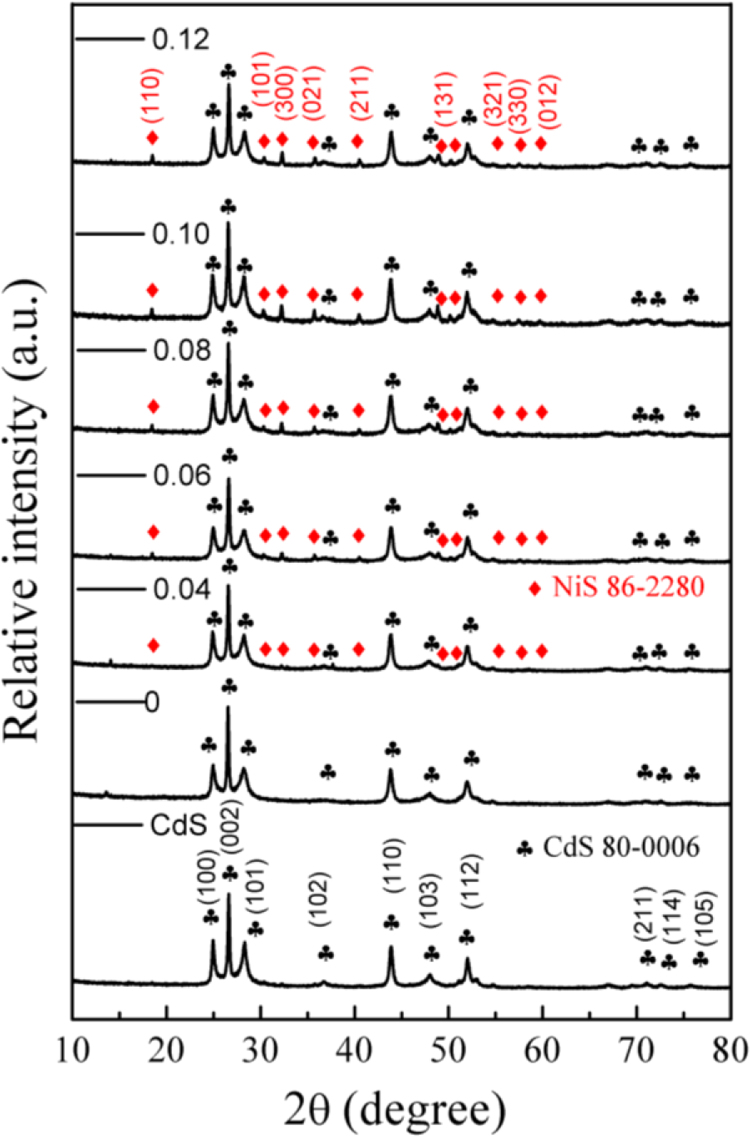
XRD patterns of pure CdS NFs and NiS/CdS NFs HSNC photocatalysts prepared with a constant Ni/Cd FMR of 0.6 and different amounts of NaH2PO2·H2O: 0, 0.4, 0.6, 0.8, 1.0 and 1.2 mmol, while the amount of Cd(NO3)2·4H2O was fixed at 1 mmol (also see Table 1).